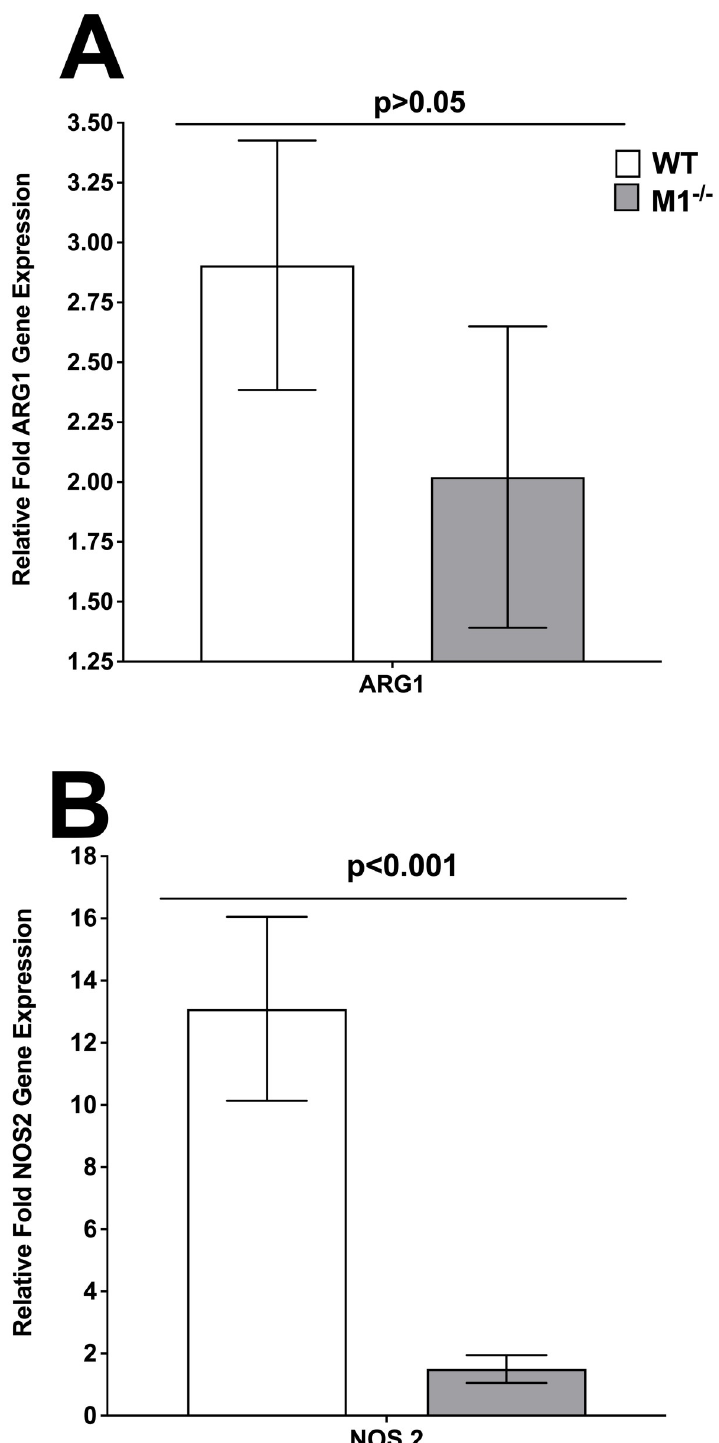
Fig 1. Validation of macrophage phenotype. Bone marrow-derived macrophages from WT and M1 -/- mice were polarized into M1 and M2 phenotypes as described in Materials and methods. The cells were then infected with 1 pfu/ cell of HSV-1 strain McKrae for 1 hr and harvested 24 hr PI. Total RNA was isolated and subjected to TaqMan qRT-PCR using ARG-1 (M2 marker) and NOS2 (M1 marker) specific primers. Expression of ARG1 and NOS2 mRNA was normalized to that of GAPDH RNA. Each bar represents the mean ± SEM from two independent experiments (N = 4). Panels: A) ARG1; and B) NOS2.